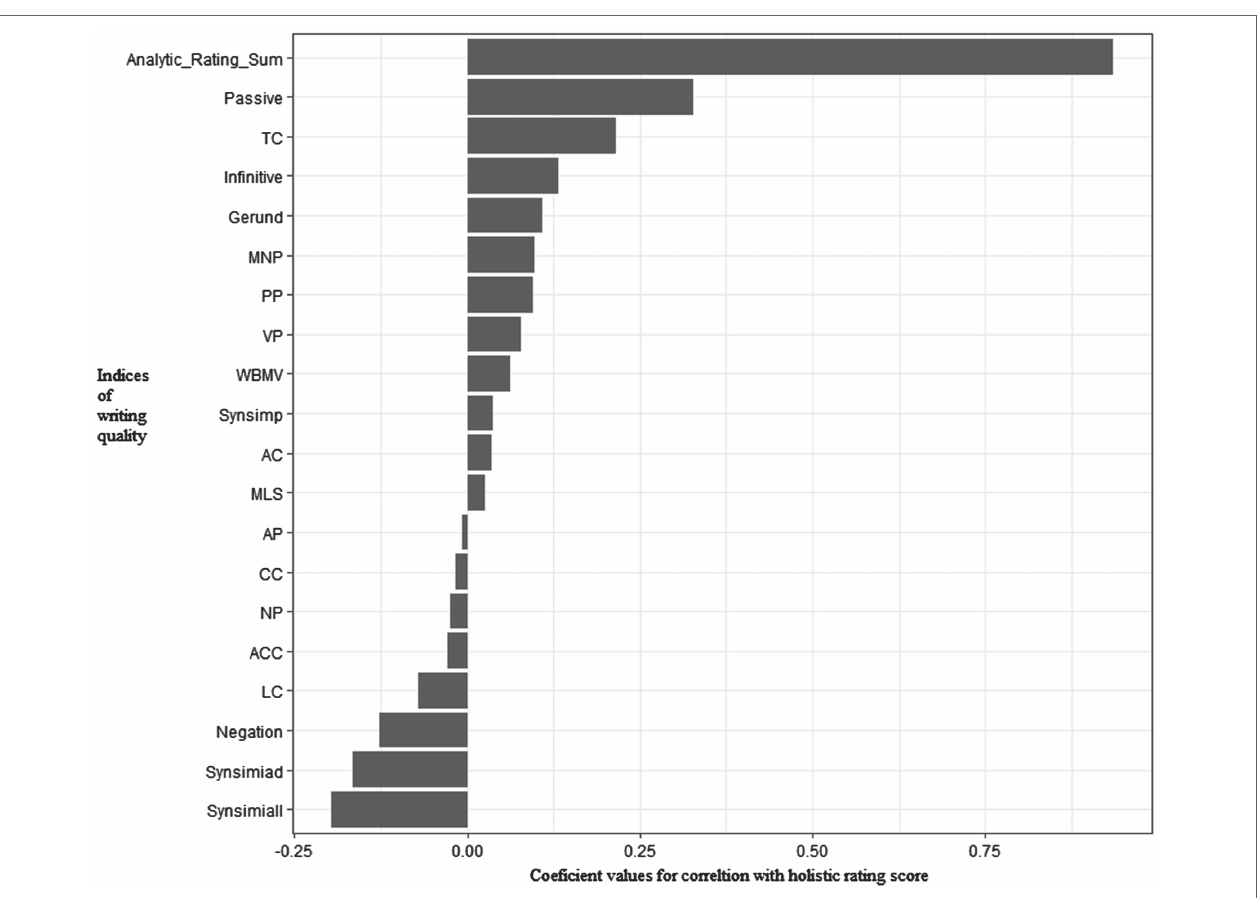
FIGURE 2 | Patterns of correlations between syntactic complexity indices and holistic